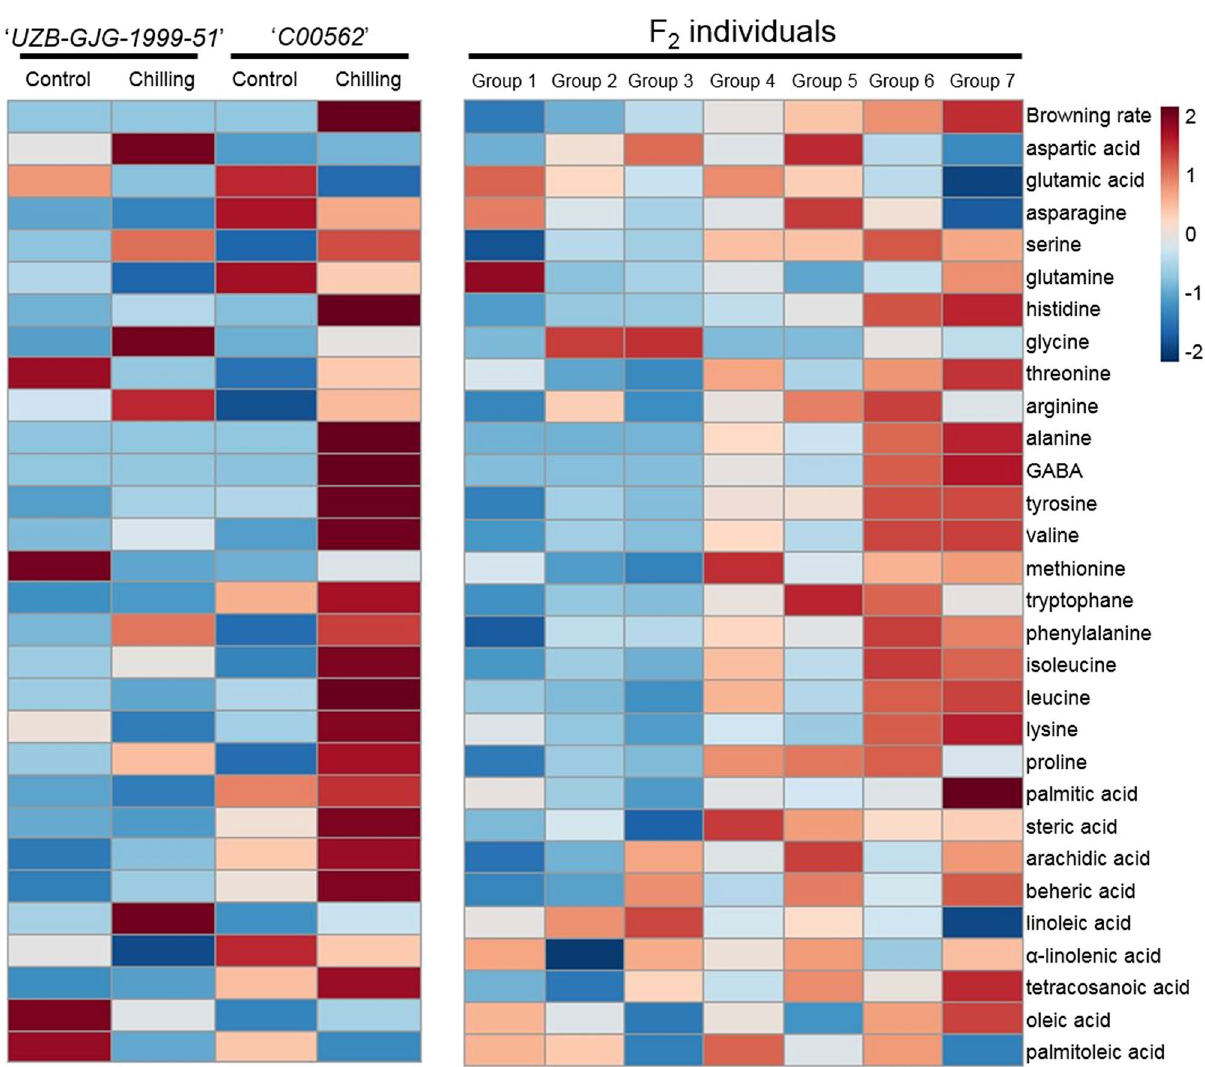
Figure 3. Heat map of free amino acids and fatty acids in ‘ UZB-GJG-1999–51 ’, ‘ C00562 ’, and F 2 groups after chilling treatment at 2 °C for 3 weeks. The groups were divided from Group 1 to Group 7, and each seed browning rate was 0–10%, 10–20%, 20–30%, 30–40%, 40–50%, 50–60%, and > 60%, respectively. The mean fold- change magnitude for overall metabolites in each group is color-coded. Increases are shown in red while blue indicates decreases. This figure was created with freely available MetaboAnalyst (version 5.0, https:// www. metab oanal yst. content and total phenolic content, and CaERF3 and CaERF5 expression levels were positively correlated with linoleic acid content. To clearly visualize the correlation between seed browning and the analyzed factors, a correlation network was analyzed based on Pearson’s correlation coefficient ( ≥|0.7|, p < 0.05) (Fig. 5B). Through correlation network analysis, it was confirmed that CaJAR1 expression level was negatively correlated with the seed browning rate and CaERF11 expression level (r = − 0.7996 and − 0.7254, respectively). In addition, isoleucine, leucine, and valine, belonging to BCAA, were positively correlated with each other. In terms of fatty acids, oleic acid was negatively correlated with aspartic acid (r = − 0.7158), and palmitic acid and linoleic acid, and the representative saturated and unsaturated fatty acids, respectively, were negatively correlated (r = − 0.9530). CaJAR1 and CaERF11 expression levels and hydrogen peroxide content, which were correlated with the seed browning rate in the heat-map and network analyses, were used to confirm the individual correlation with the seed browning rate (Fig. 6). CaJAR1 expression level was confirmed as the coefficient of determination ( R 2 ) with a seed browning rate of 0.6393 ( p < 0.001) (Fig. 6A). The R 2 for seed browning with CaERF11 expression level and hydrogen peroxide content were 0.5809 and 0.4365, respectively (Fig. 6B,C).